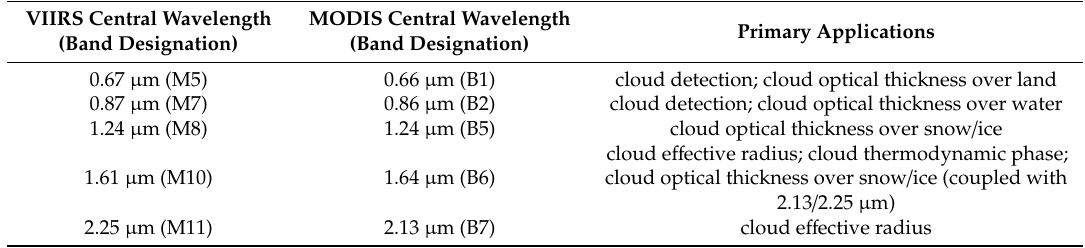
Table1. TheSNPPandNationalOceanicandAtmosphericAdministration(NOAA)-20VIIRSshortwave spectral channels, and Aqua MODIS analogs, considered in this radiometric assessment. Primary uses within the cloud mask and optical property retrieval algorithms are also